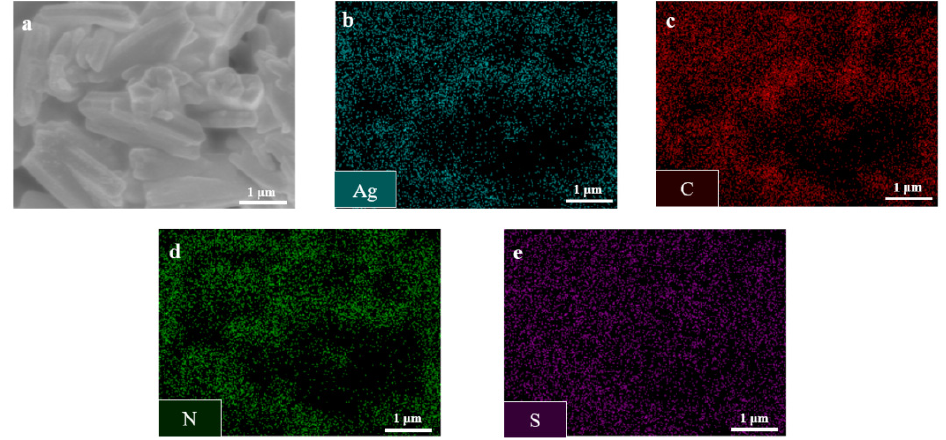
Figure 5. ( a ) SEM morphology of P3HT@Ag 2 NCN composite film; ( b – e ) EDS elemental analysis of P3HT@Ag 2 NCN composite film. Table 1. Mass distribution of elements in EDS.